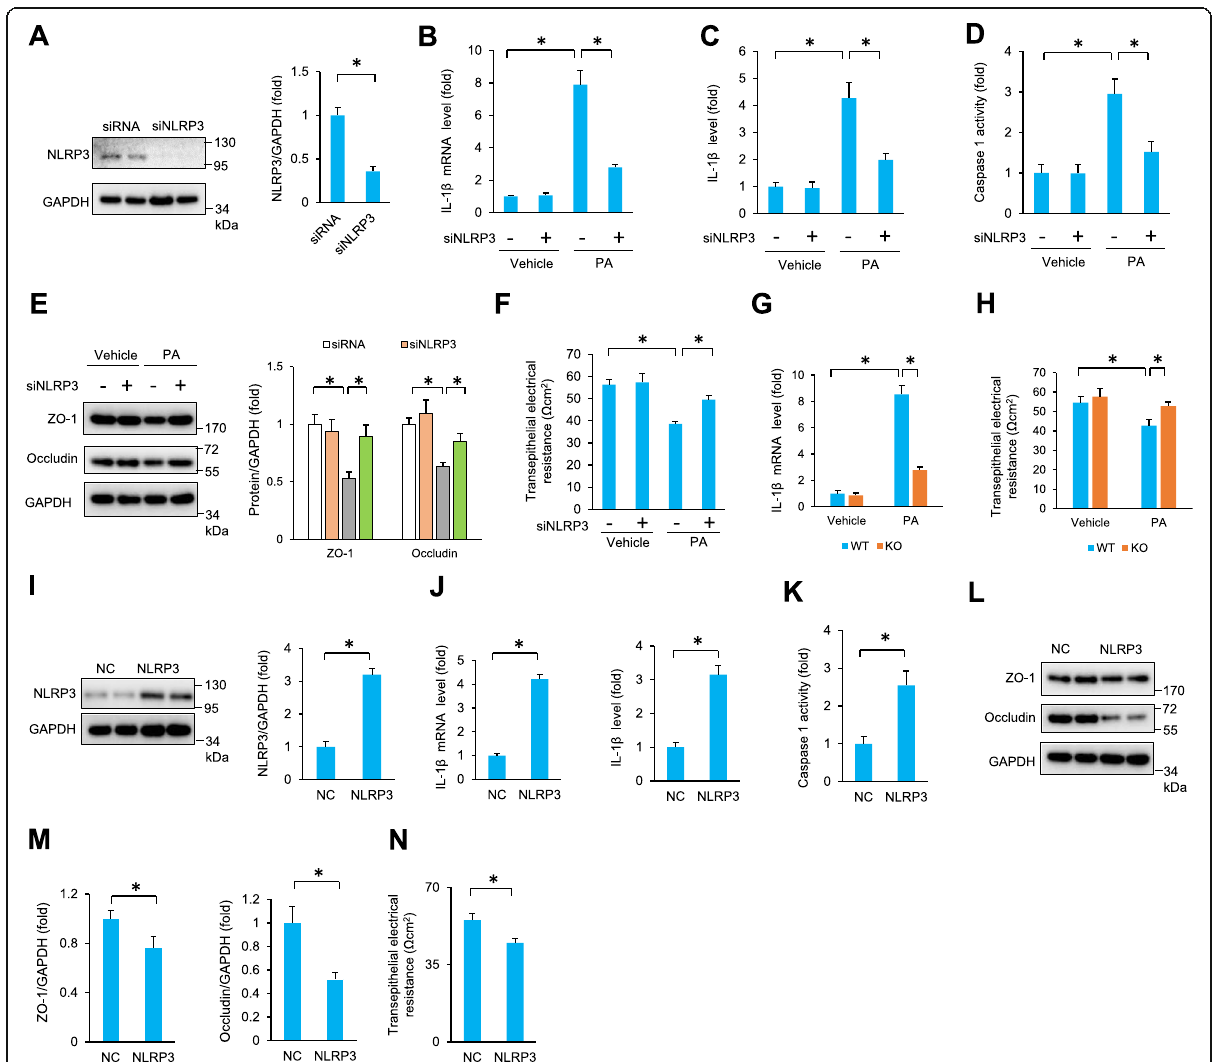
Fig. 2 NLRP3 deficiency attenuated palmitic acid-induced impairment of SCs in vitro. A NLRP3 expression was detected in TM4 cells at 24 h after siNLRP3 infection ( n = 6). B , C The IL-1 β mRNA and protein expression in TM4 cells after PA incubation for 24 h ( n = 6). D Caspase 1 activity in TM4 cells after PA incubation for 24 h ( n = 6). E The protein expression of ZO-1 and occludin in TM4 cells after PA incubation for 24 h ( n = 6). F Transepithelial electrical resistance was detected in TM4 cells after PA incubation for 48 h ( n = 6). G The IL-1 β mRNA in primary SCs isolated from NLRP3-deficient mice ( n = 4 – 5). H Transepithelial electrical resistance was detected in primary SCs isolated from NLRP3-deficient mice ( n = 4 – 5). I NLRP3 expression was detected in TM4 cells at 48 h after NLRP3 overexpression ( n = 6). J The IL-1 β mRNA and protein expression in TM4 cells at 48 h after NLRP3 overexpression ( n = 6). K Caspase 1 activity in TM4 cells at 48 h after NLRP3 overexpression ( n = 6). L , M The protein expression of ZO-1 and occludin in TM4 cells at 48 h after NLRP3 overexpression ( n = 6). N Transepithelial electrical resistance was detected in TM4 cells at 48 h after NLRP3 overexpression ( n = 6). Data are presented as the mean ± SD. For A and I – N , the statistical analysis was carried out by Student ’ s two-tailed t test; for others, the statistical analysis was carried out by one-way ANOVA. * P < 0.05 vs the matched